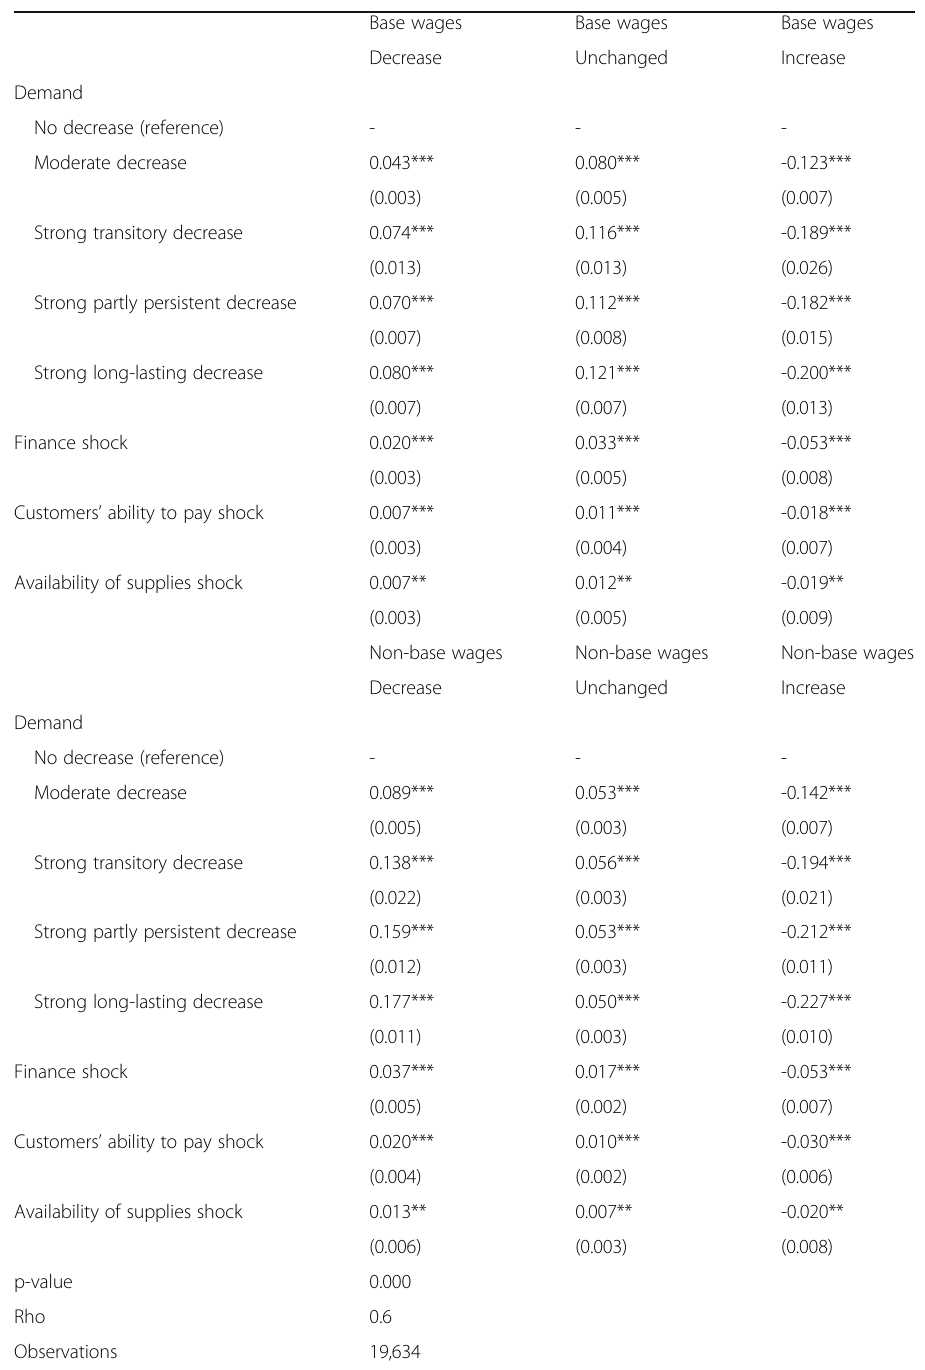
Table 8 Base wage and non-base wage adjustment depending on shock intensity, SUR